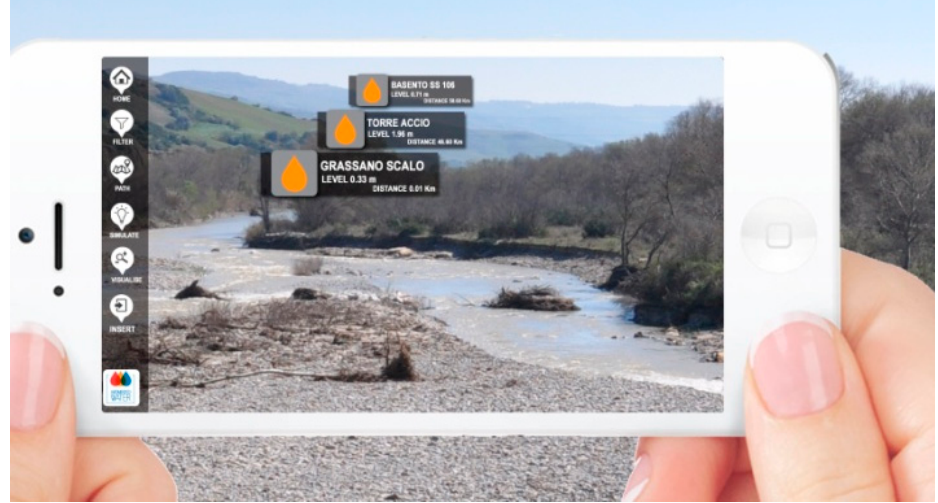
Figure 3. Augmented Reality (AR) representation of gauge stations along the river through coloured drops. Labels show the station name, the user-station distance, and the instantaneous water level. The size of the billboard increases when the station is nearer.